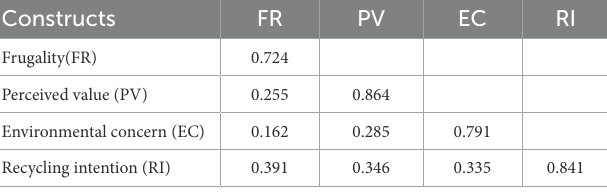
TABLE 3 Discriminant validity